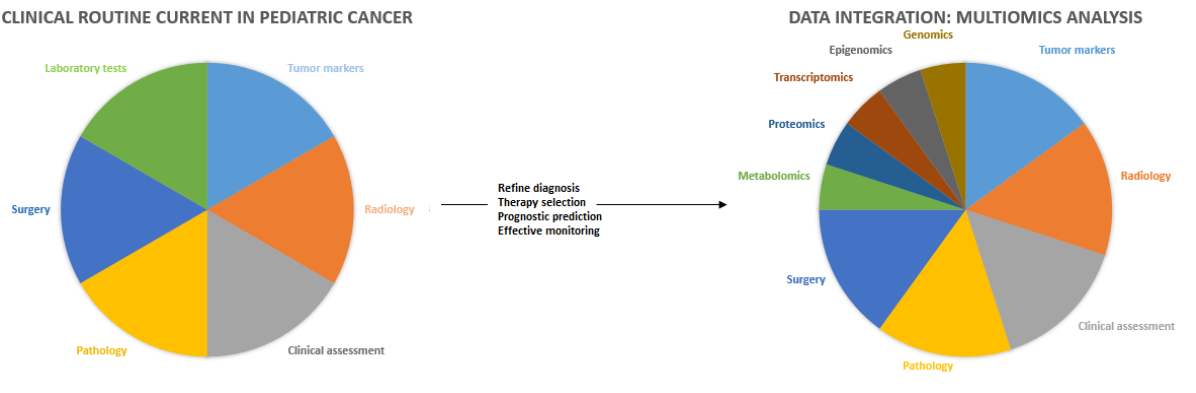
Figure 1. Clinical and genetic landscape of pediatric cancers: multidisciplinary network approach.